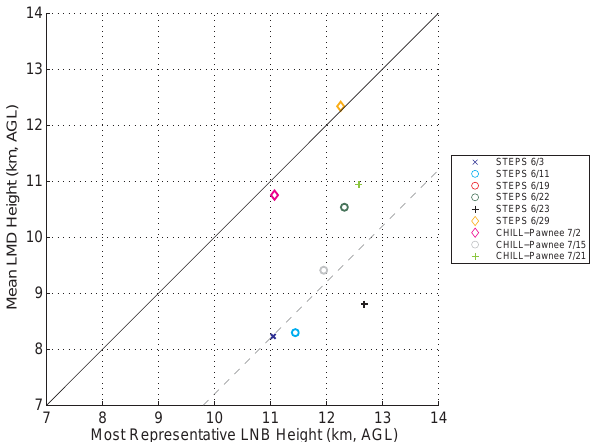
Fig. 5. Most representative LNB height (km) plotted versus mean LMD height (km, see text for details). Each case is designated by different color, and the shapes designate storm type: x for single cell, plus sign for multicell, circle for convective line, and diamond for supercell. The LNB versus LMD one-to-one line is plotted for reference as a solid gray line; a line representing LNB 2.8km above the LMD is plotted as dashed